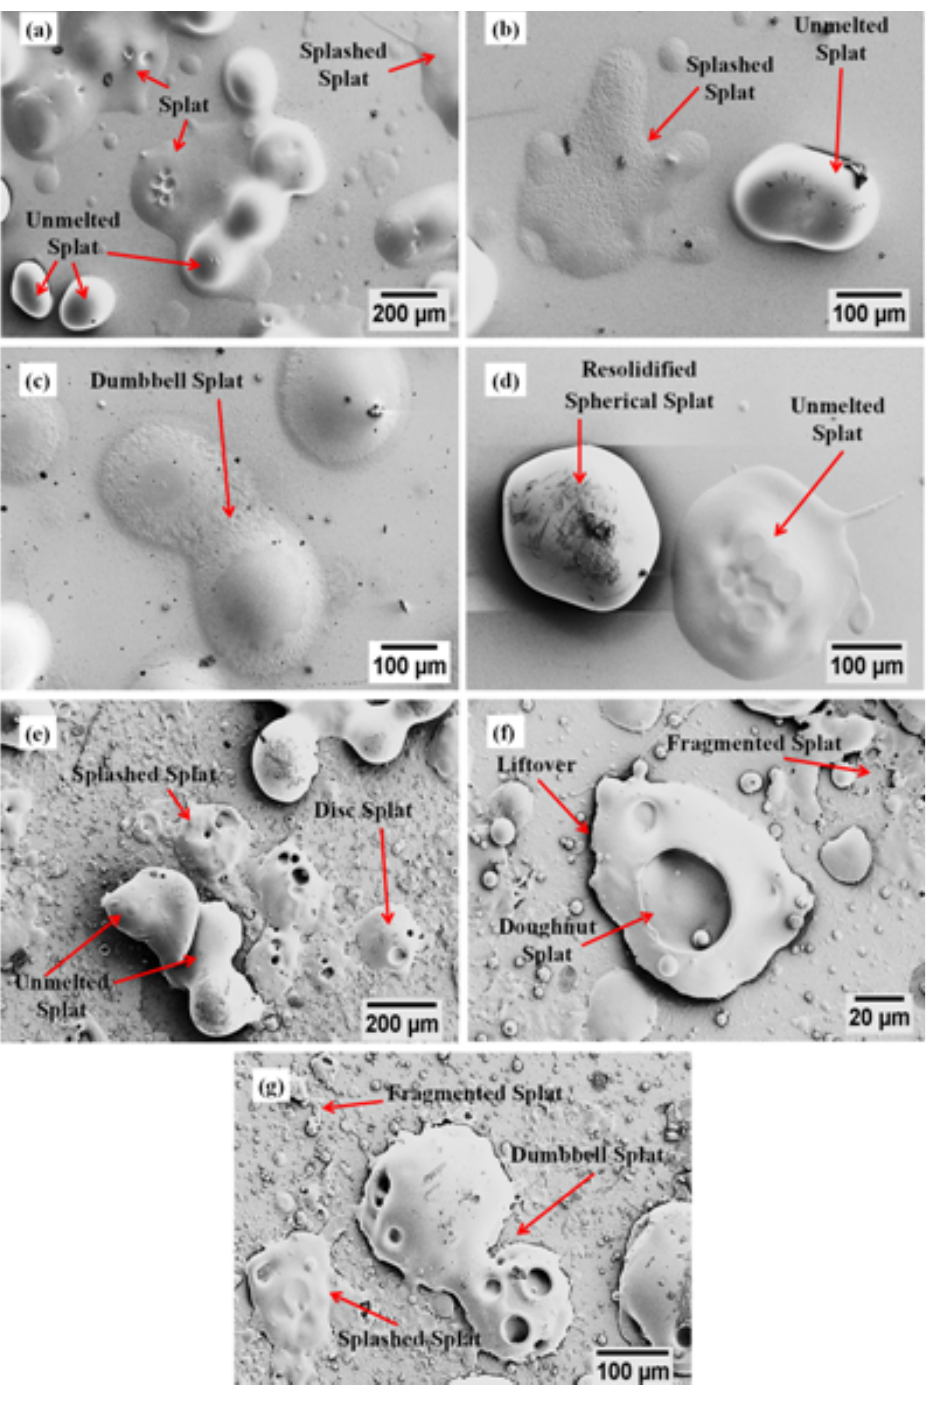
Figure 10. Type of splats ( a ) and ( b ) At 25 cm stand-off distance. ( c ) At 20 cm stand-off distance. ( d ) At 30 cm stand-off distance on glass substrates. ( e ), ( f) and ( g ) At 20 cm stand-off distance on mild steel